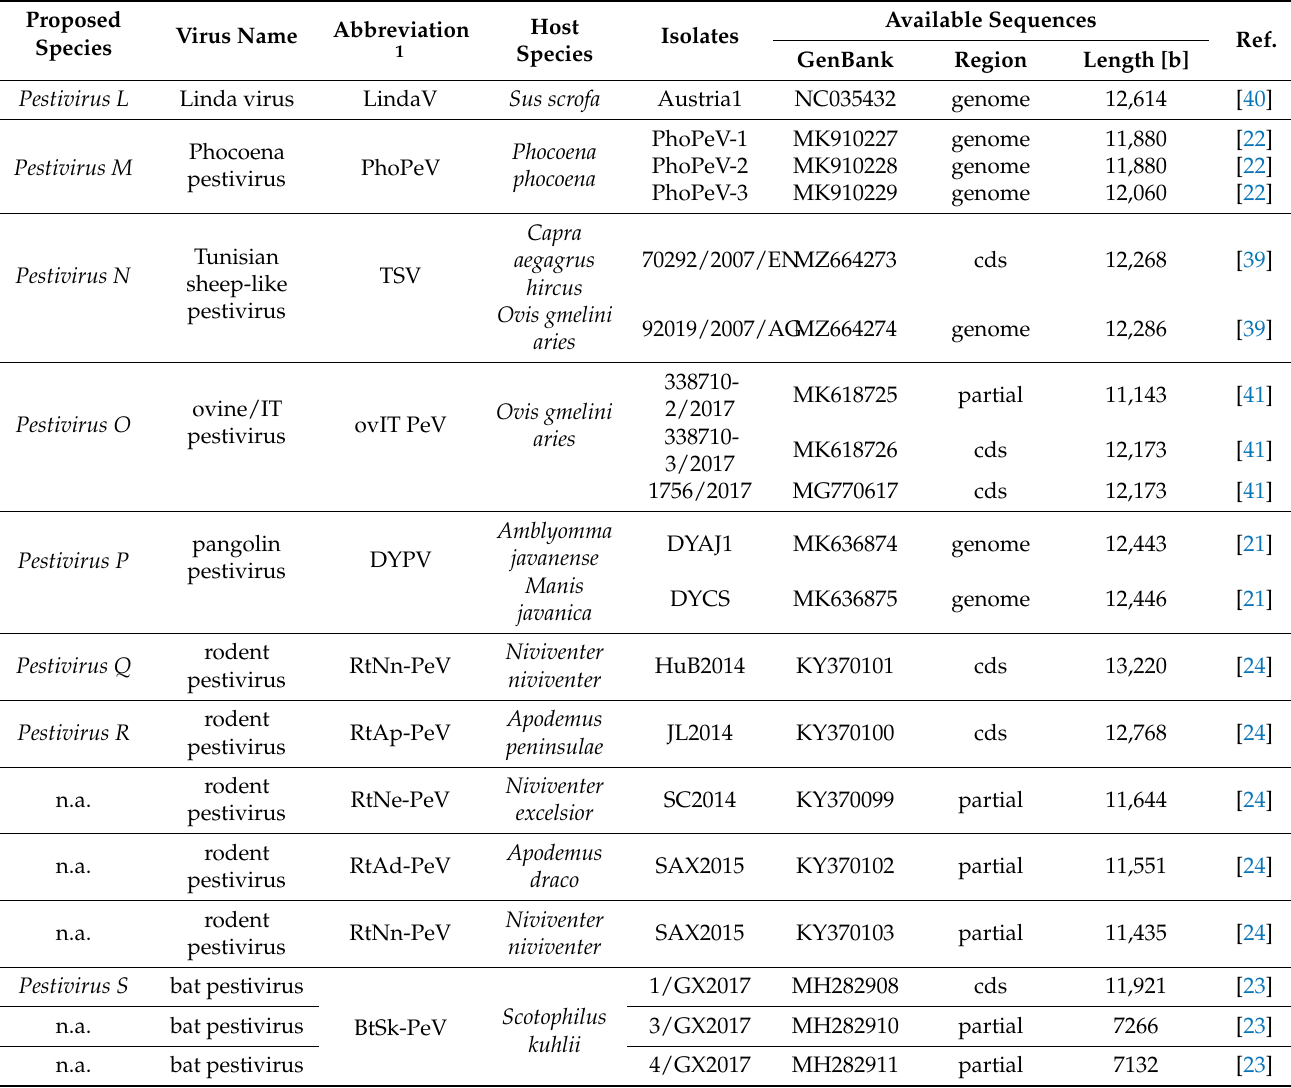
Table 3. Recently reported pestivirus